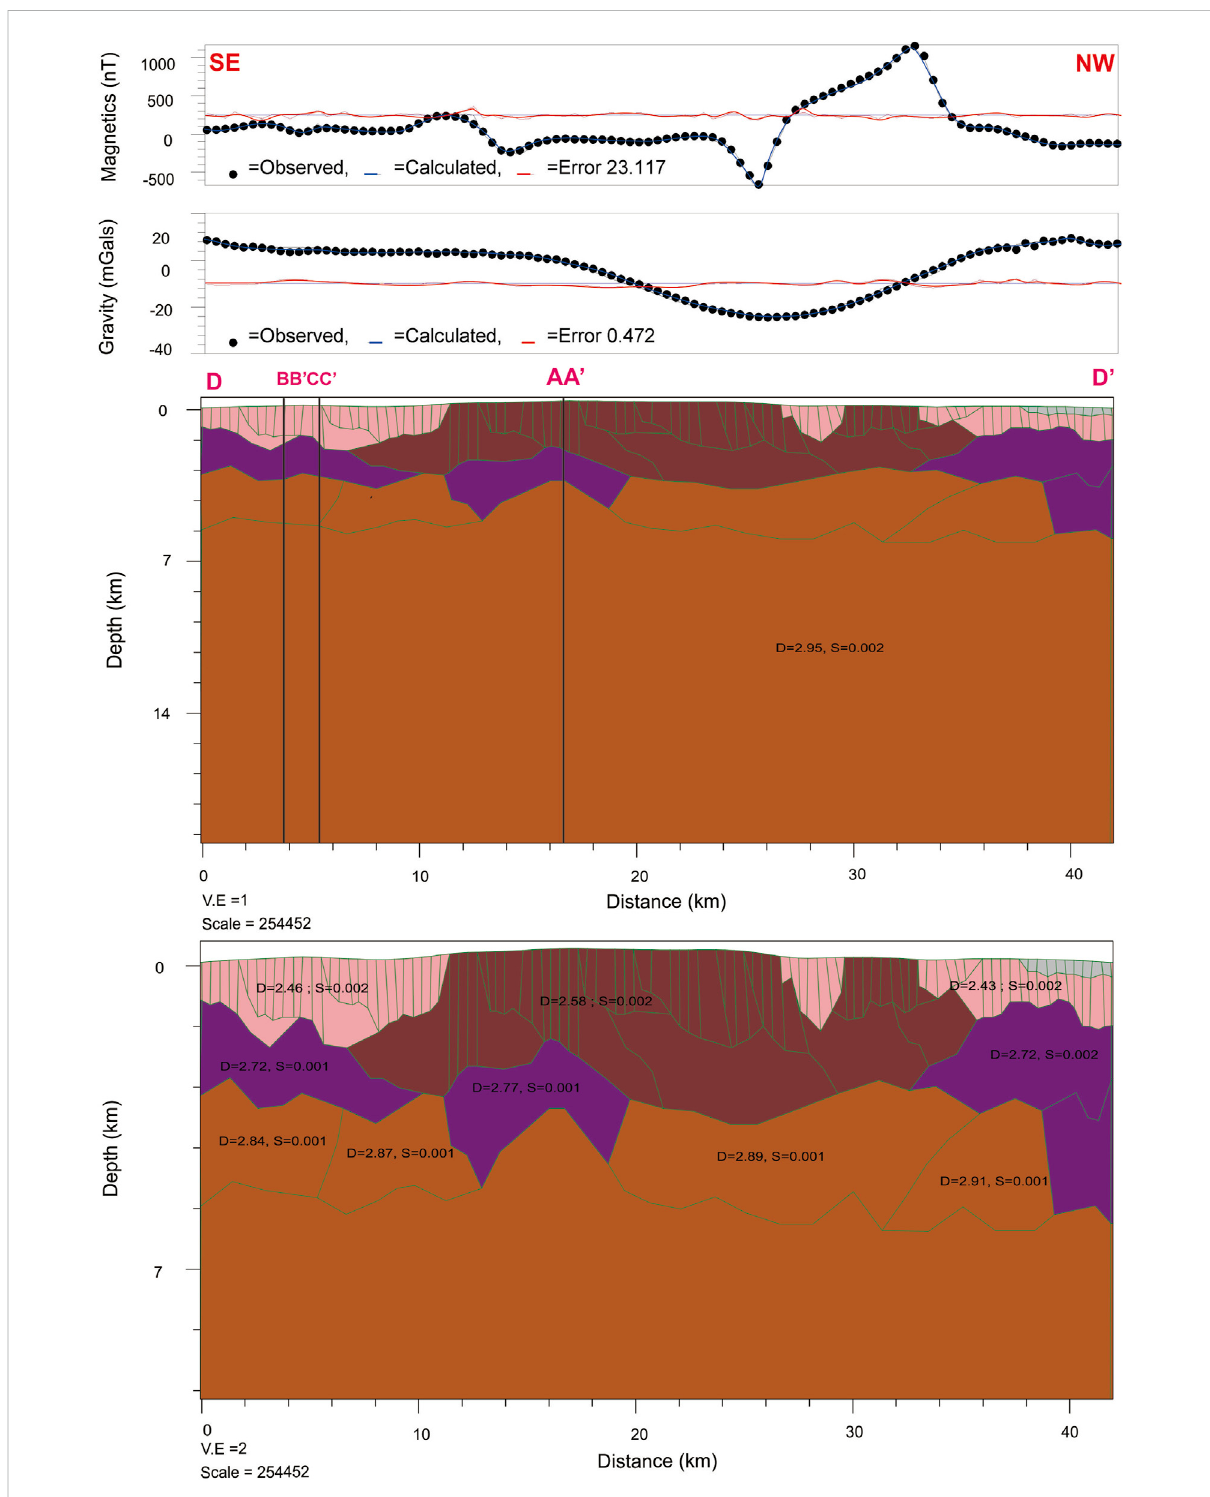
FIGURE 6 2D modeling of magnetic and gravity data of the D-D ′ pro fi le in the Sianok segment of GSF showing slivers of Permian metamorphic rocks encased in the basement rocks. See the text for details. This fi gure uses the same legend as that in Figure